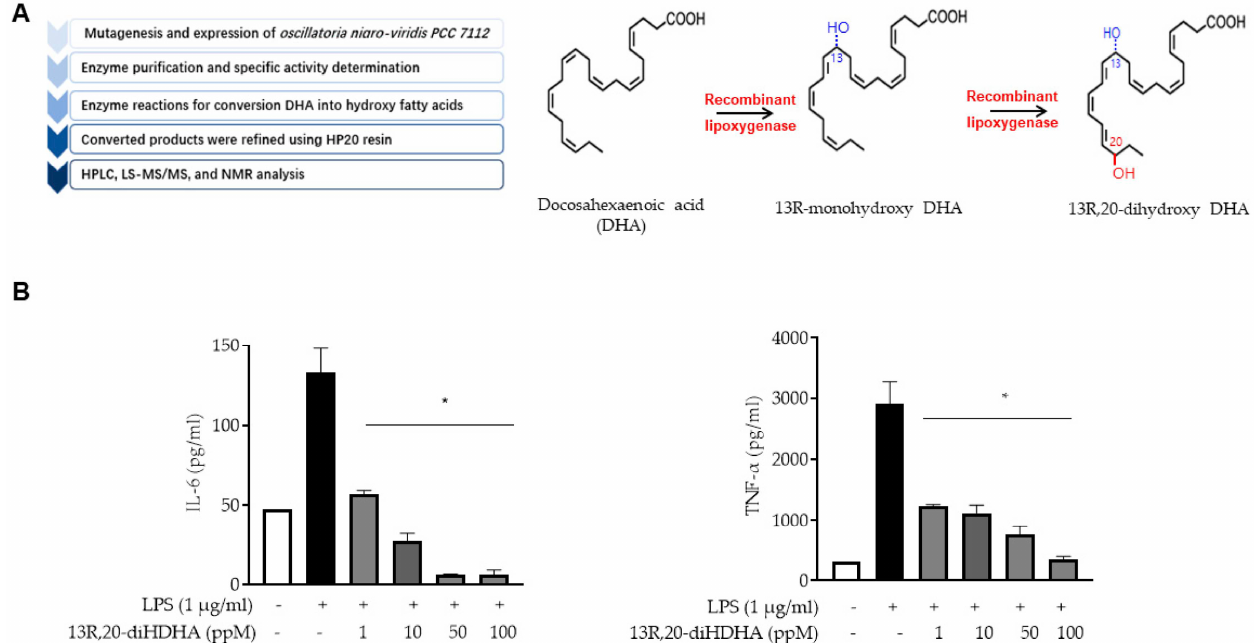
Figure 1. 13 R ,20-diHDHA inhibits IL-6 and TNF- α production, as assessed by a cytokine assay. ( A ) Summary of the process used to produce 13R,20-diHDHA. ( B ) The secretions of IL-6 and TNF- α , by LPS-stimulated (inflamed) macrophages were inhibited by various concentrations of 13 R ,20-diHDH. THP1 cells were treated with PMA to generate macrophages, which were stimulated with LPS (1 µ g/mL) for 48 h with or without 13 R ,20-diHDHA. Cytokines were measured by ELISA. The data from triplicate experiments are presented as the mean ± SD. * p < 0.05 versus the LPS-treated positive control